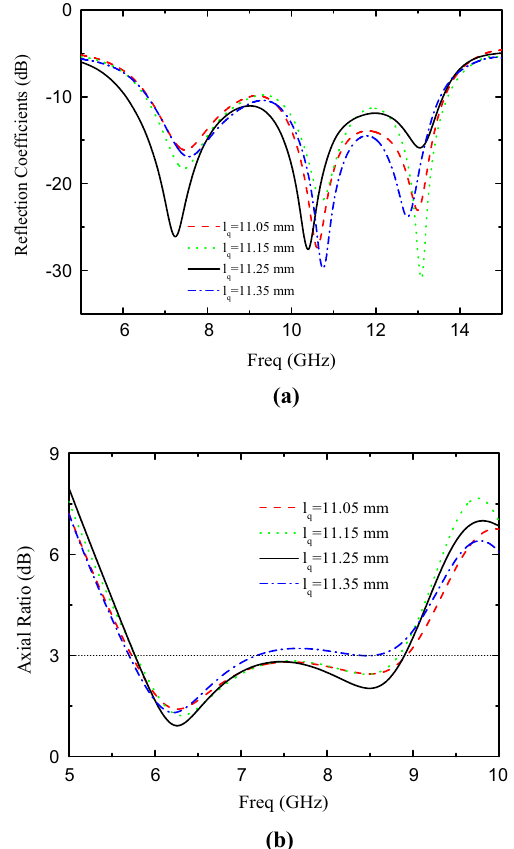
Fig. 5 The effect of different l q on the performance of the proposed antenna. a Reflection coefficients at different frequencies with different l q values. b AR at different frequencies with different l q